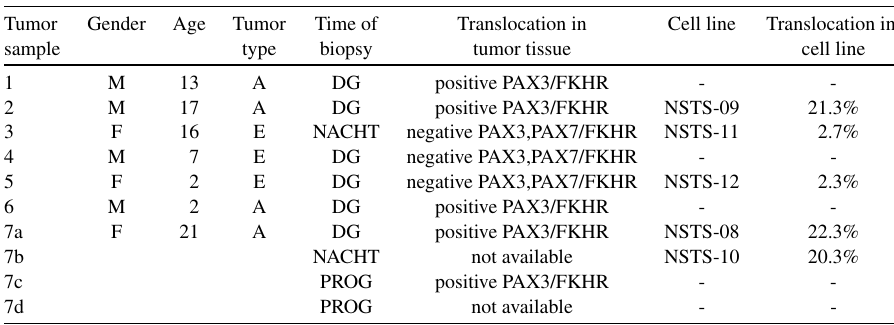
Description of patient cohort and characterization of analyzed